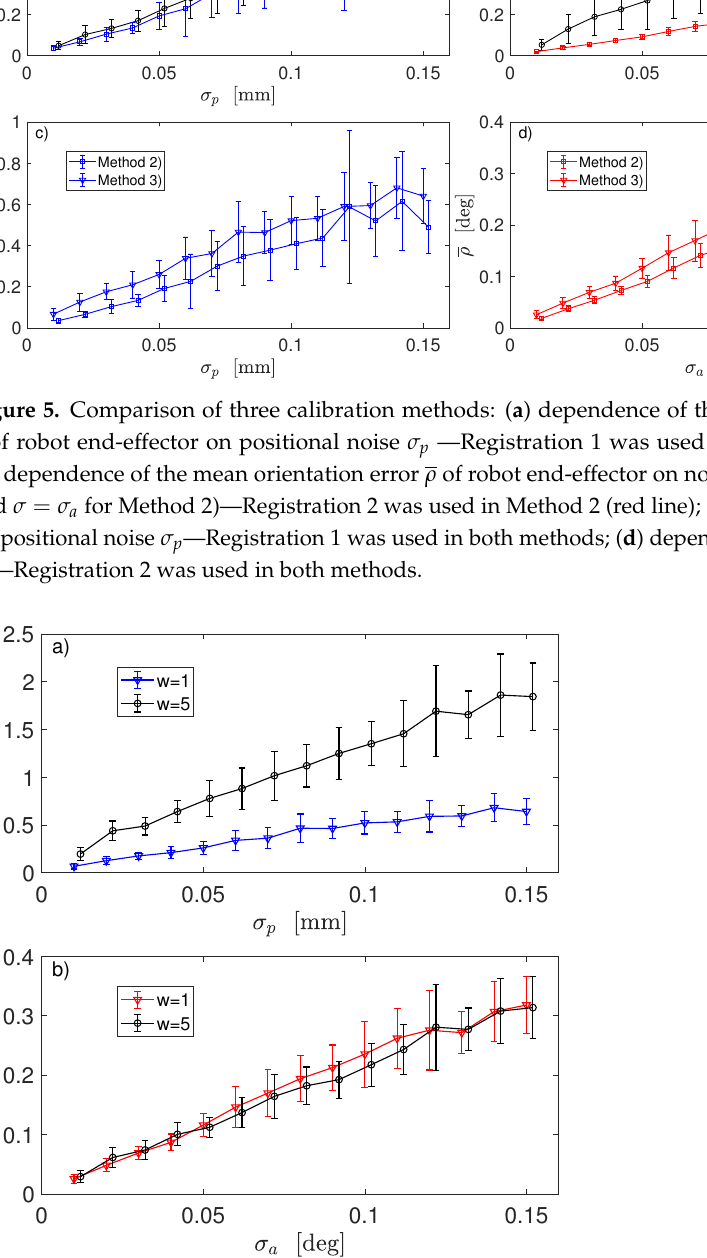
Figure 6. Comparison of robot calibrations using two different scaling factors w in error function Err full in Method 3: ( a ) dependence of the mean positional error v of robot end-effector on positional noise σ p in sensor 6D data—Registration 1 was used; ( b ) dependence of the mean orientation error ρ of robot end-effector on angular noise σ a in sensor 6D data—Registration 2 was used. Data generated using large deviations from the default DH